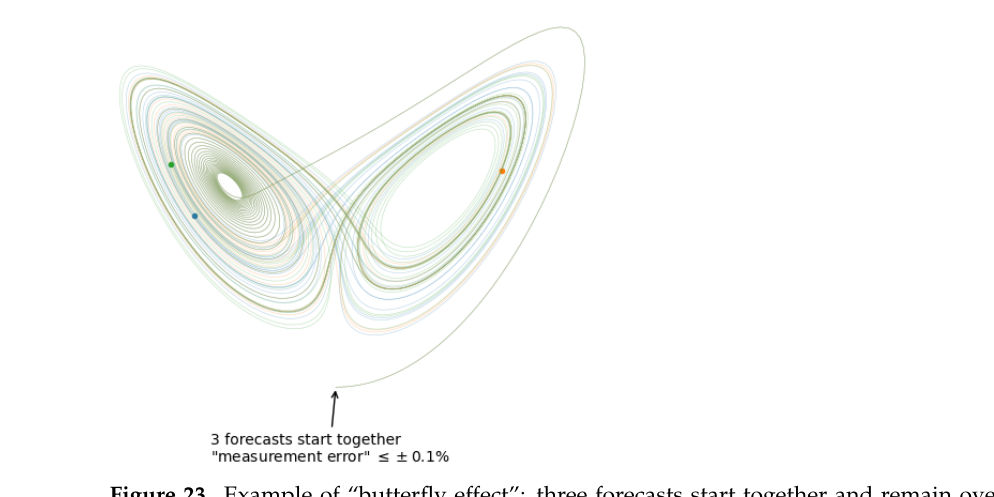
Figure 23. Example of “butterfly effect”: three forecasts start together and remain overlap for a while, but as time evolves, each can end up in any region of the manifold, independent from its initial